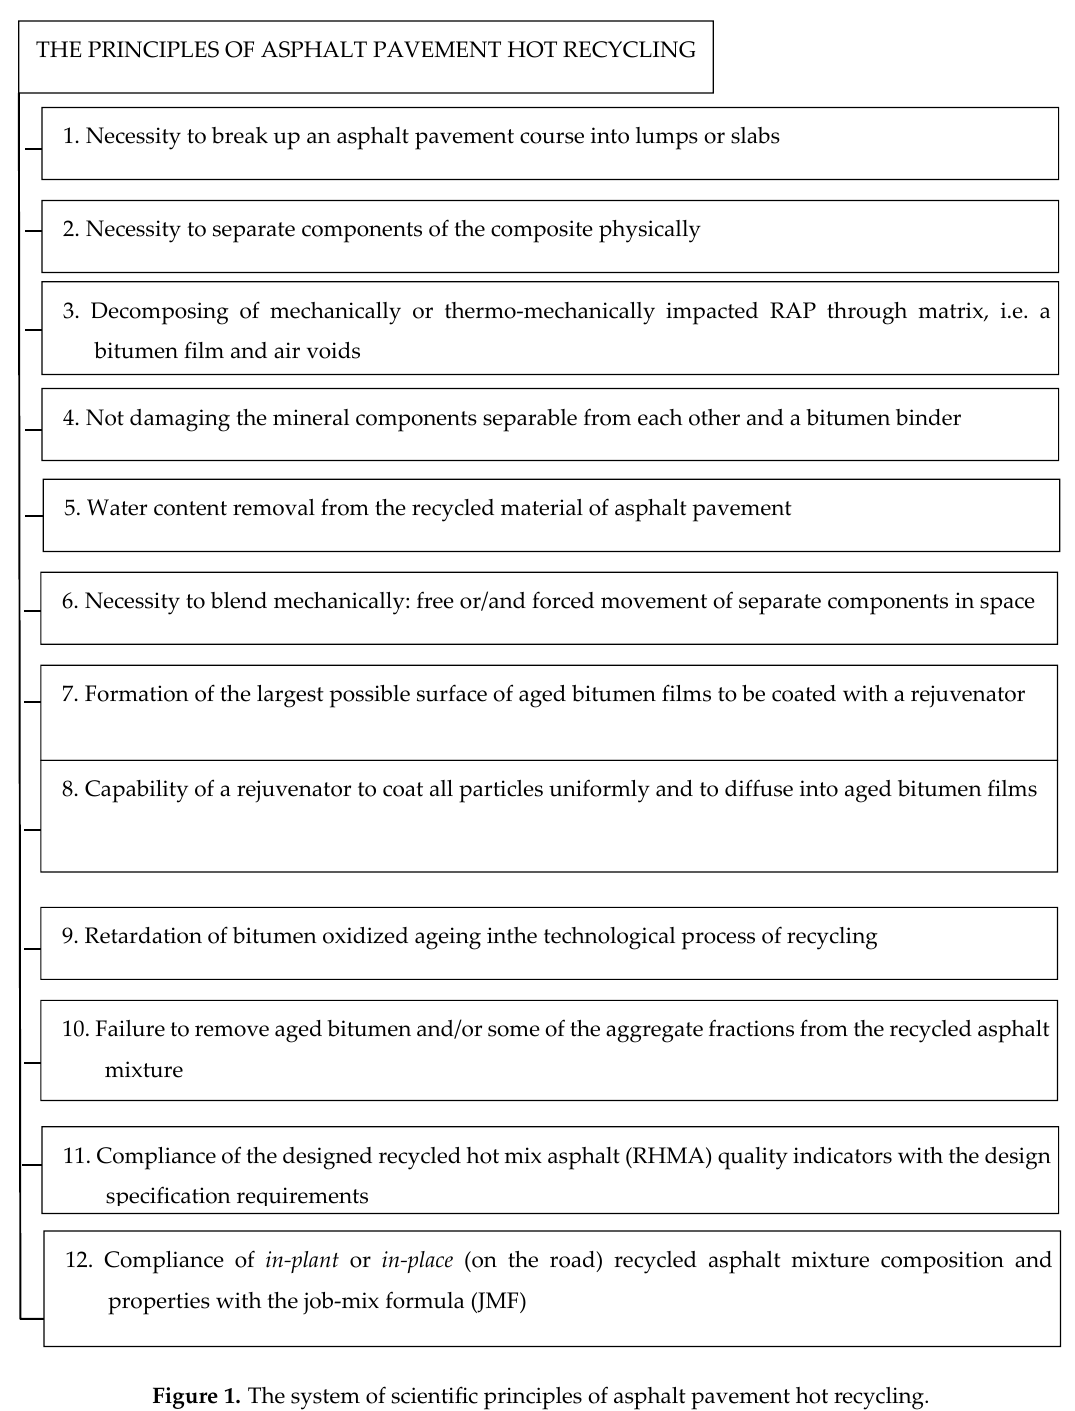
Figure 1. The system of scientific principles of asphalt pavement hot recycling.